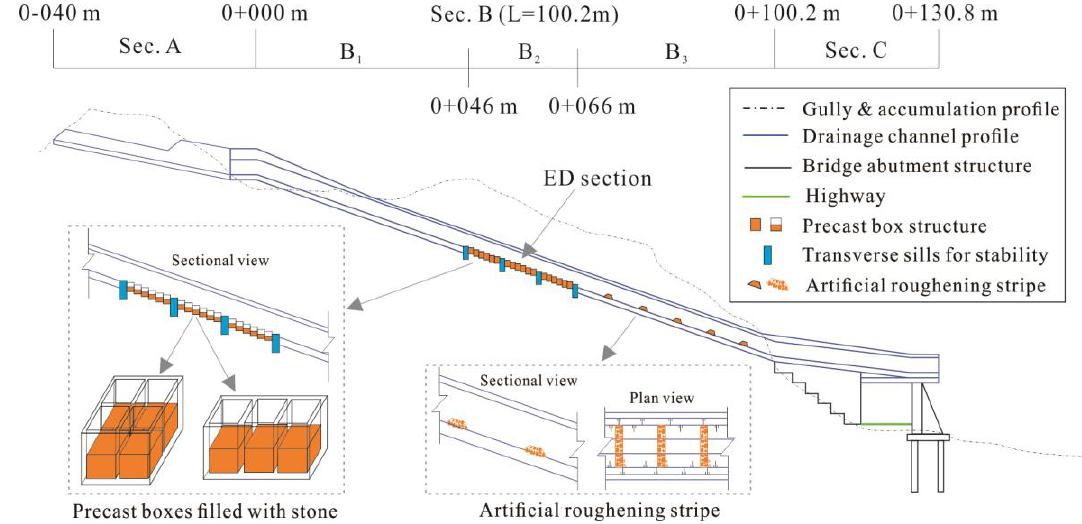
Figure 6. Design drawing of longitudinal section of DCLG in Xiaogangjian gully.